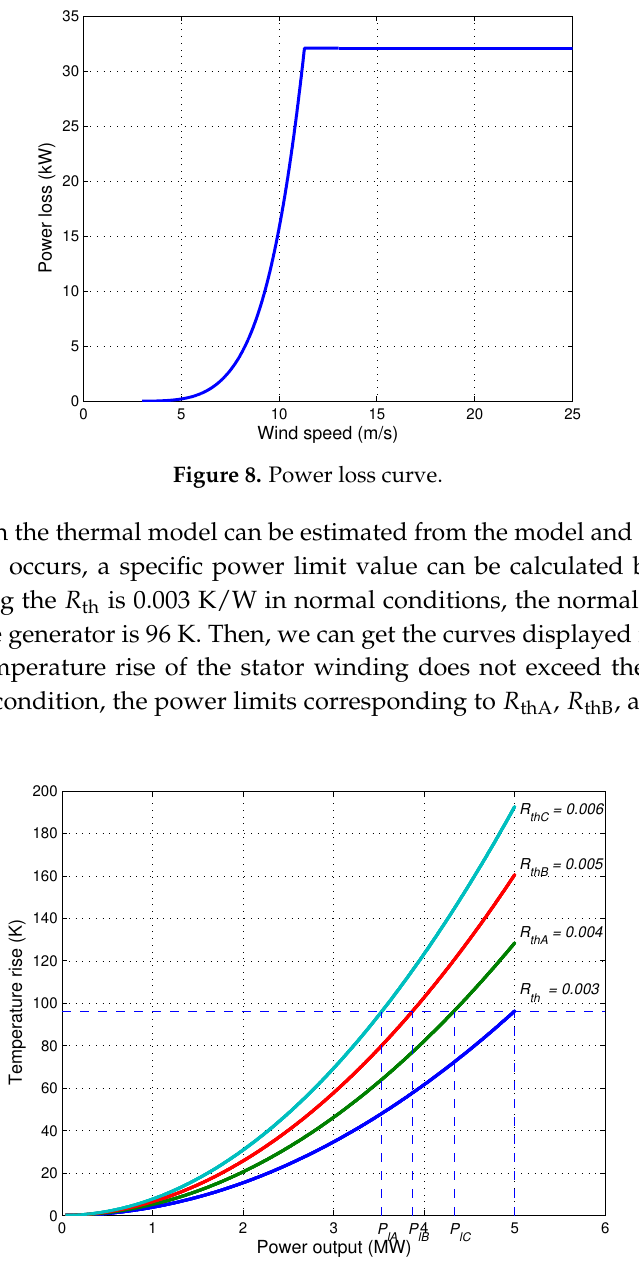
Figure 9. Temperature rise curves under different thermal